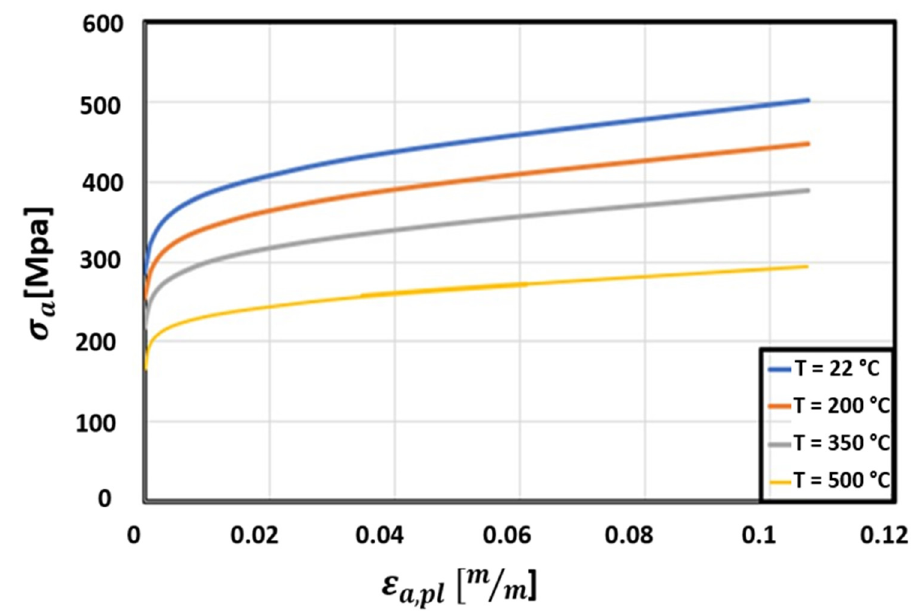
Figure 3. Stress-strain curves for CuCrZr at different temperature levels [18].